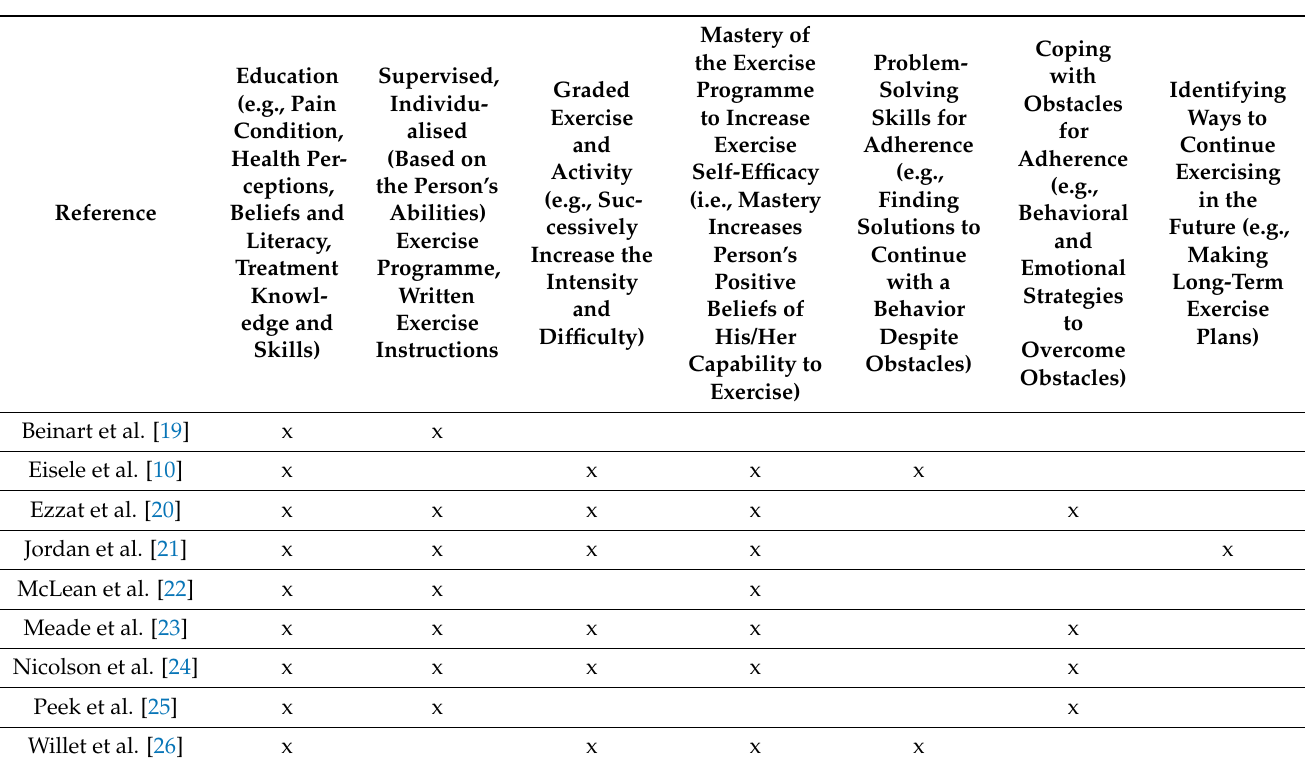
Table 3. Adherence to exercise behaviour components categorized according to the behavioural wheel provided by Michie et al. [42] regarding capability, motivation and opportunity. Capability: Capability consists of a person’s physical and psychological knowledge and skills needed to engage in a target